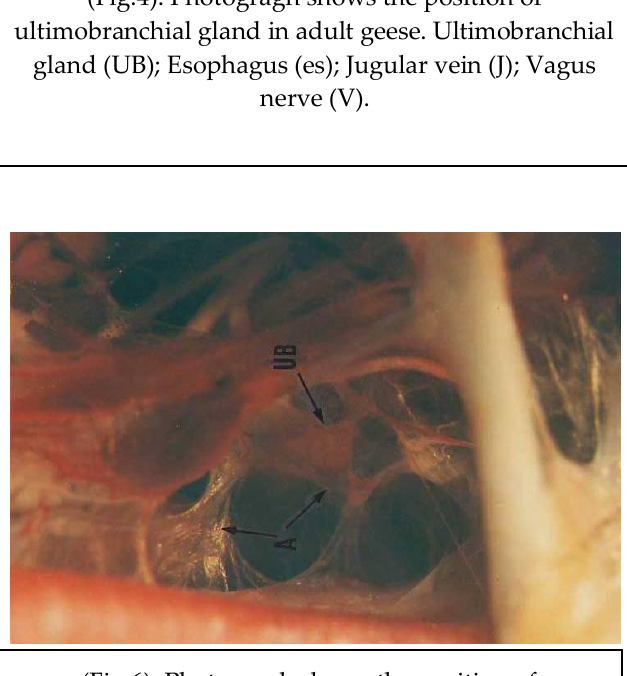
(Fig.6): Photogragh shows the position of ultimobranchial gland in adult geese. Ultimobranchial gland (UB) is embedded in